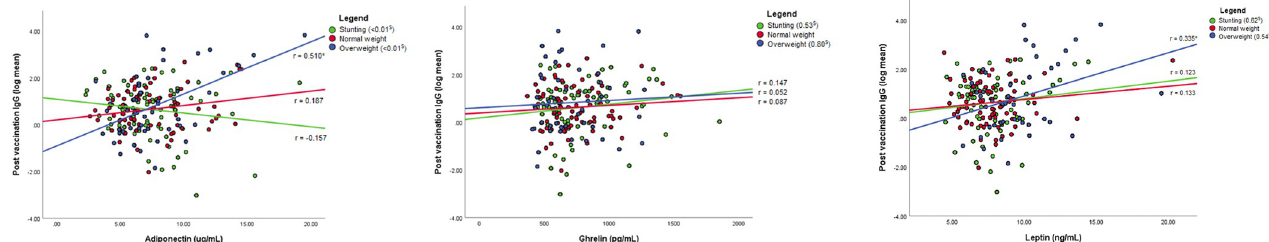
Fig 2. A: Correlation between adiponectin and post vaccination pneumococcal IgG antibody concentrations. Correlation, shown by a linear regression line, between pre-vaccination adiponectin levels and post-vaccination log-transformed pneumococcal IgG antibody concentrations for stunted, normal weight and overweight children. r = Pearson correlation coefficient. � p = < 0.05. $ P-value value of interaction term in multivariable regression model (Table 3). B: Correlation between ghrelin and post vaccination pneumococcal IgG antibody concentrations. Correlation, shown by a linear regression line, between pre-